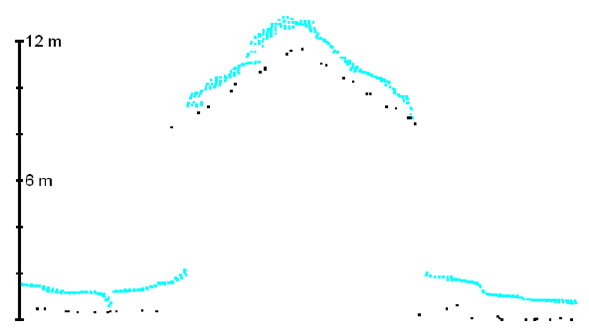
Figure 3. Profile of the reference ALS point (black) cloud and IM point cloud with offset +1 m (cyan, custom merging technique)